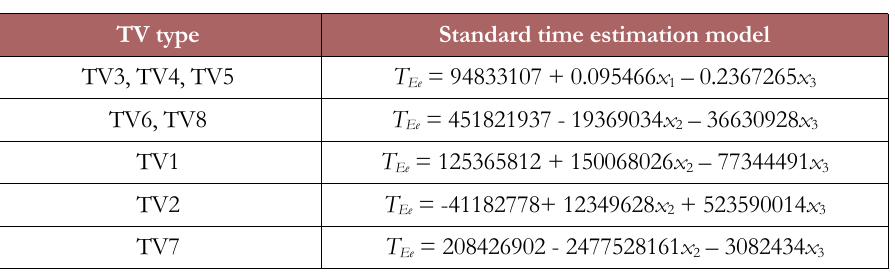
Table 13. Non-linear optimization models to estimate standard times. Case study: TV set assembly